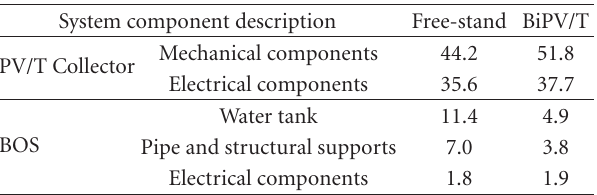
Table 4: Distribution of embodied energy in PV/T collector systems.